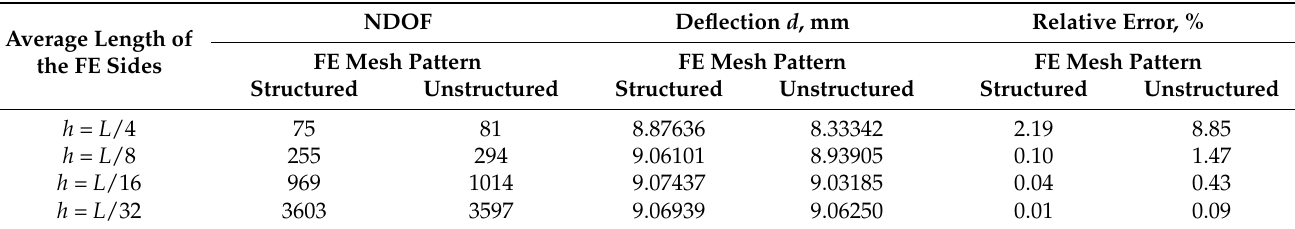
Table 4. Central Deflection d (mm) of the plate and the relative error.